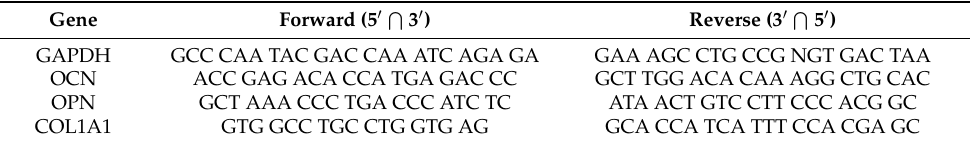
Table 1. Primers deployed for qPCR: glyceraldehyde 3-phosphate dehydrogenase (GAPDH; reference gene), osteocalcin (OCN), osteopontin (OPN) and type I collagen alpha 1 (COL1A1). Gene Forward (5 (cid:48) (cid:84) 3 (cid:48)